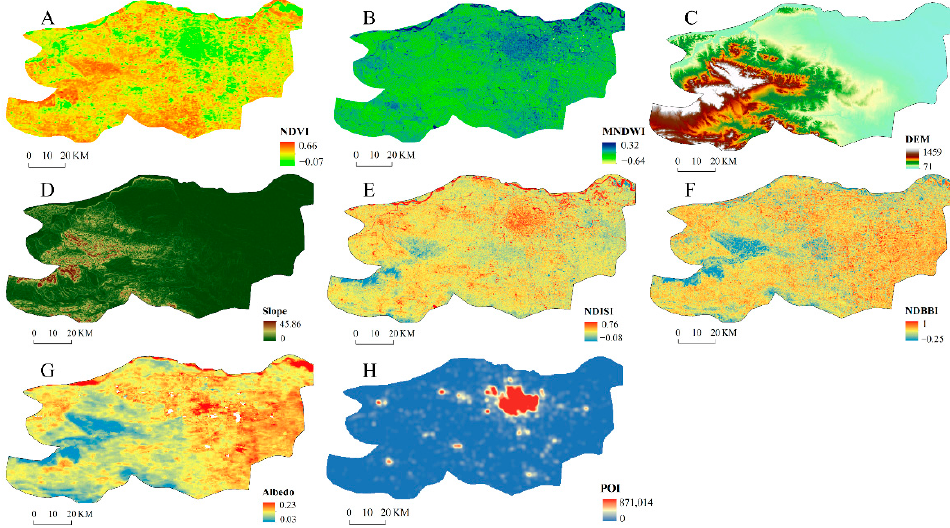
Figure 5. Linear relationship between influencing factors and LST in Zhengzhou: ( A ) NDVI; ( B ) MNDWI; ( C ) DEM; ( D ) Slope; ( E ) NDISI; ( F ) NDBBI; ( G ) Albedo; ( H ) POI.